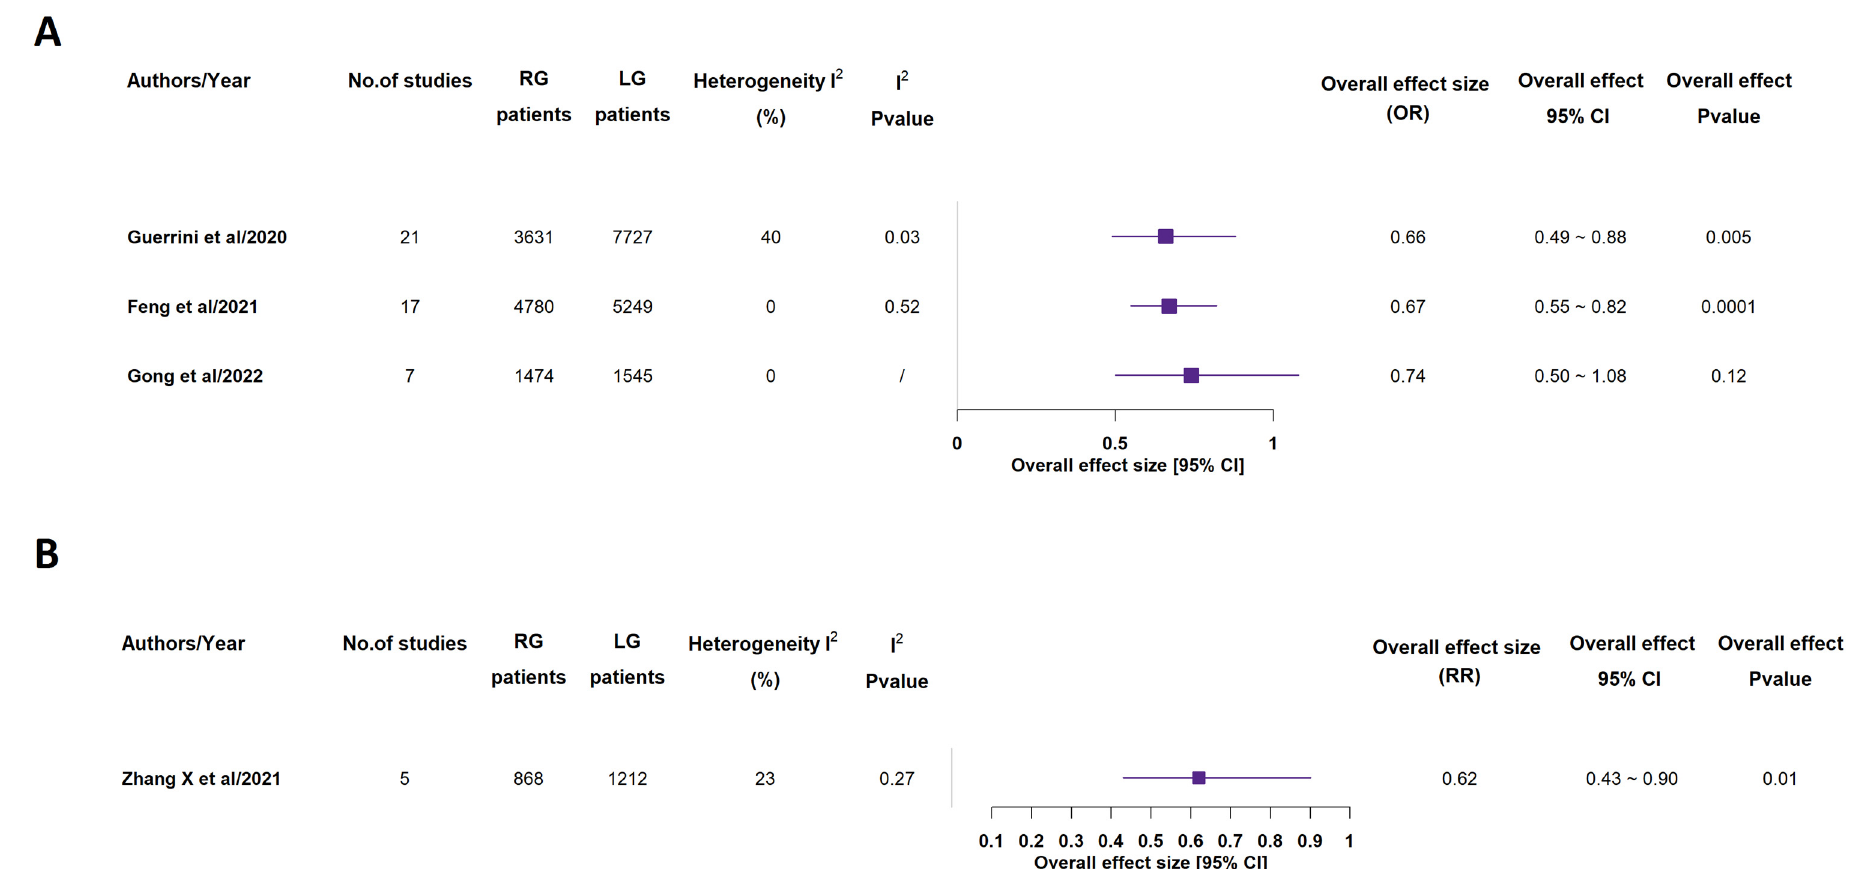
Figure 9. CD > III complications rate. RG = Robotic gastrectomy; LG = Laparoscopic gastrectomy; OR = odds ratio ( A ); RR = risk ratio ( B )